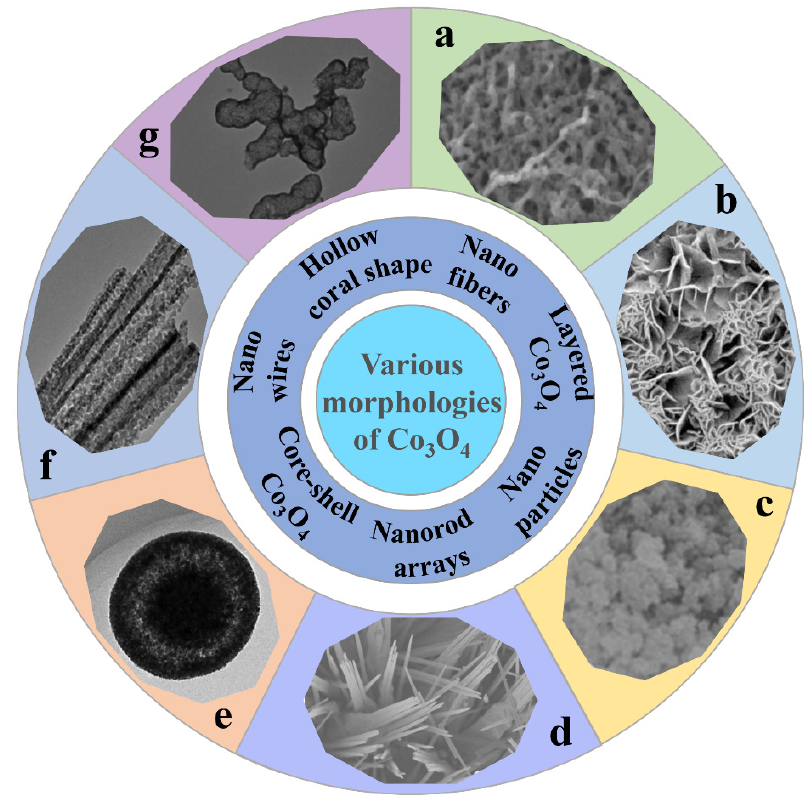
Figure 2. Various morphologies of Co 3 O 4 . ( a ) Nano fibers; reprinted with permission from ref. [51] . ( b ) Layered Co 3 O 4 ; reprinted with permission from ref. [52] . ( c ) Nano particles; reprinted with permission from ref. [53] . ( d ) Nanorod arrays; reprinted with permission from ref. [54] . ( e ) Core-shell